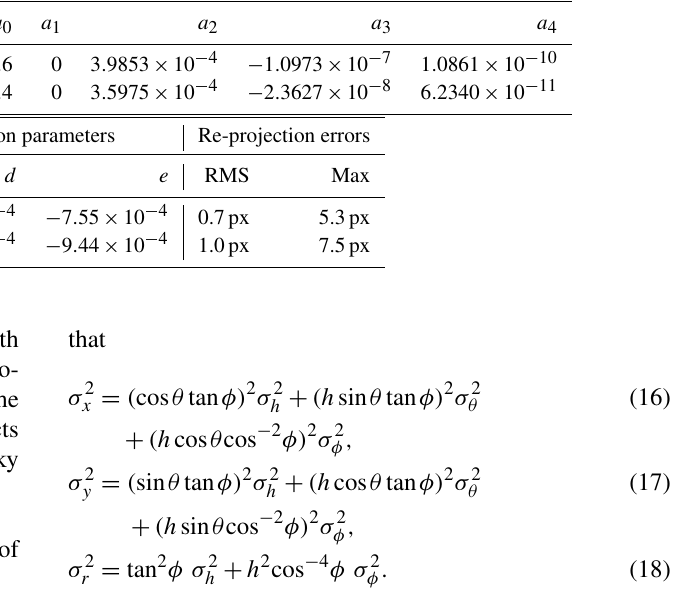
Table 1. OcamCalib calibration results for cameras 1 and 2. Parameters are described in Eqs. (3) and (4) in Sect. 2.2. Principal